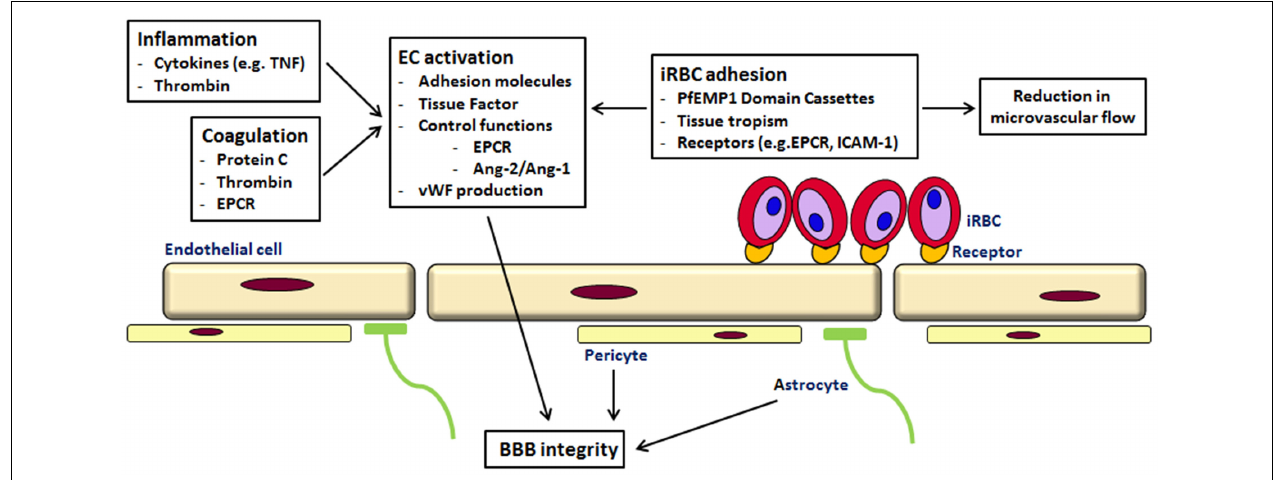
FIGURE 1 | Cerebral malaria—a multi-component disease. Cytoadherence of iRBC of the PfEMP1-DC8 and DC13 variants to endothelial receptors (like EPCR and ICAM-1) leads to sequestration and a reduction in microvascular flow. Binding to EPCR prevents activation of protein C, normally an inhibitor of thrombin generation. Increased thrombin affects various signaling pathways leading to loss of endothelial barrier function, increased TNF, Ang2/Ang1 ratio and von Willebrand factor (for a